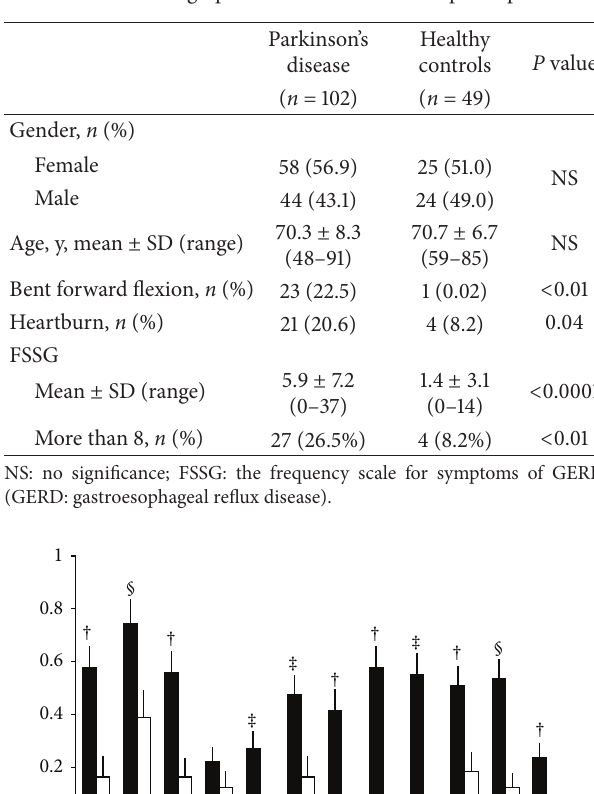
however, there were no statistically significant differences in the gender and age within our study